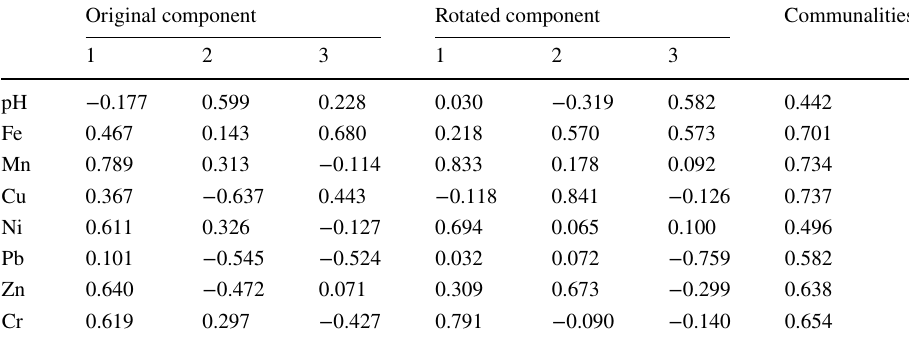
Table 12 Factor loading of the principal component extracted for the post-monsoon season